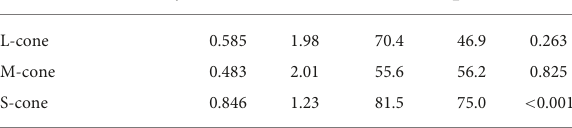
TABLE 2 ROC curve analysis of cone contrast sensitivities in TAO patients without clinical signs of